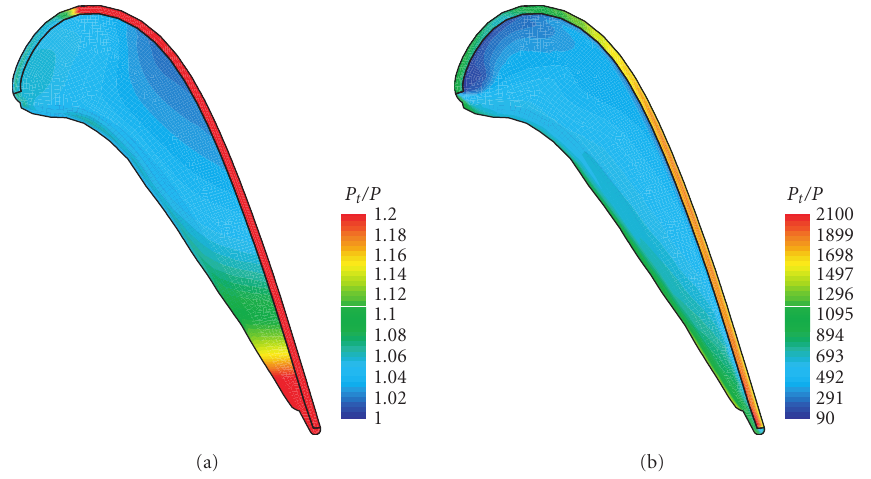
Figure 15: (a) Pressure ratio and (b) heat transfer contours on the desensitized suction-side squealer tip.